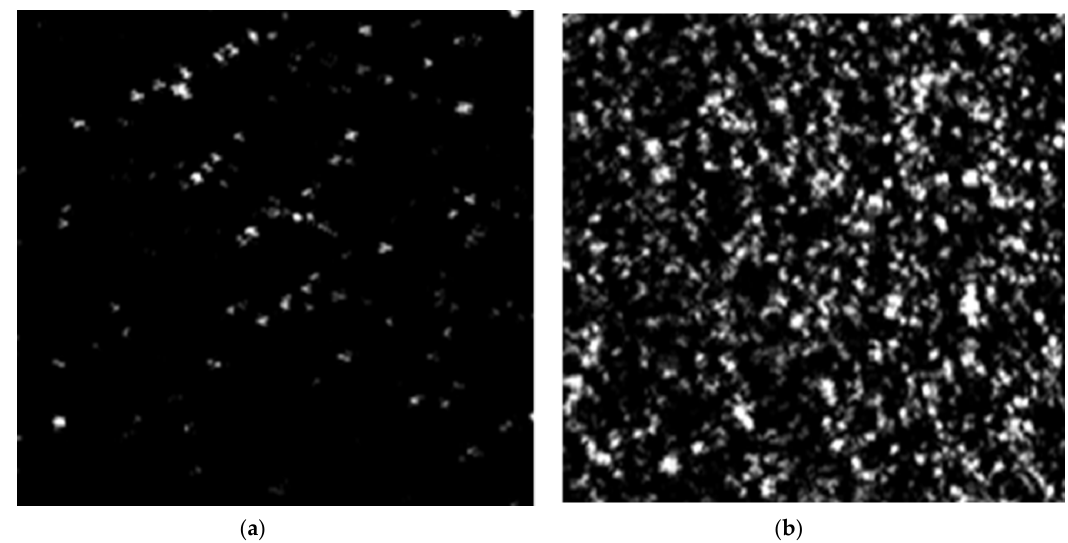
Figure 11. SAM results for the ( a ) Test-#1 and ( b ) Test-#2 specimens. Table 7. Comparison of the results obtained with the pre-trained model and SAM. Porosity Evaluation Results AM Specimen Pre-Trained Model SAM Porosity Level